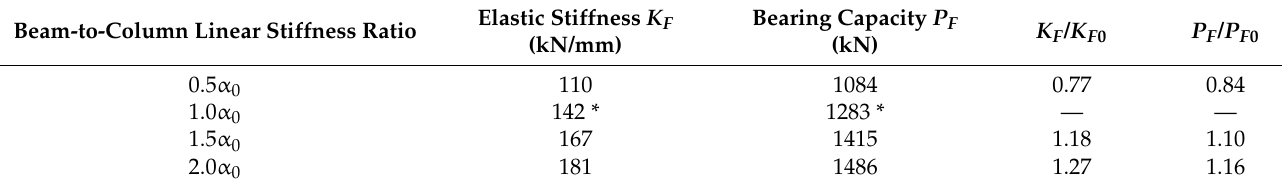
Table 4. Comparison of mechanical properties for different α values. Beam-to-Column Linear Stiffness